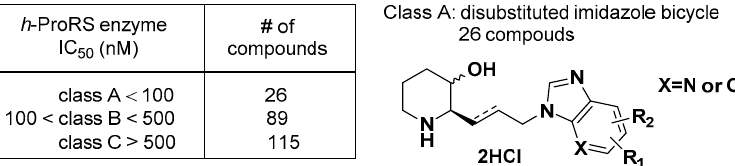
Figure 19. Human prolyl-tRNA synthetase (ProRS) inhibitors for antiproliferative diseases and the most potent imidazolyl aromatic bicycle compounds (class A).